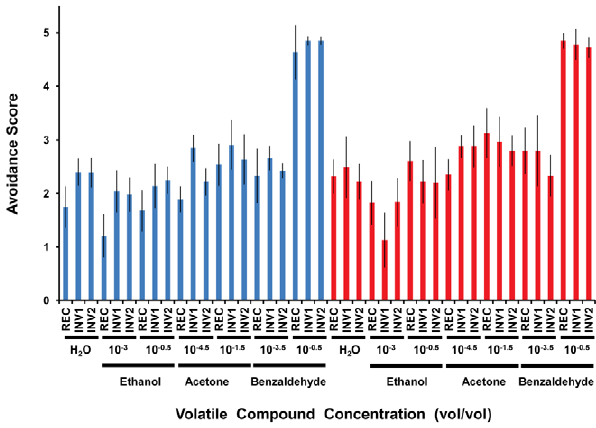
Figure 3. Olfactory response of strains with (INV1, INV2) and without (REC) the disrupted ultraconserved region CG15121– CG16894 to three different volatile compounds. Blue, females; red, males. The ‘‘dipstick’’ method was used in all cases. An avoidance score equal to 2.5 indicates indifference while values , 2.5 and . 2.5 are interpreted as attractant and repellent responses, respectively. Ethanol, acetone, and benzaldehyde were assayed at two different concentra- tions (vol/vol) deferring by several orders of magnitude in order to test the response of the strains in very different conditions. Distilled water was used as a reference for the default response when no compound is added. For females, we found statistically significant differences (Kruskal-Wallis, d.f.=2 in all cases) across strains in response to distilled water ( P , 0.0107), ethanol (concentration: 10 2 3 , P , 0.0056), ethanol (concentration: 10 2 0.5 , P , 0.0230), and acetone (concentration: 10 2 4.5 , P , 0.0002), while in males, the differences were confined to ethanol (concentration: 10 2 3 , P , 0.0183) and acetone (concentration: 10 2 4.5 , P , 0.0182). INV1 and INV2 showed significant differences in the same direction in relation to REC after accounting for multiple tests in the case of distilled water (females), ethanol (concentration: 10 2 3 , females), and acetone (concentration: 10 2 4.5 , males) (Table S14). Error bars indicate 95% CI.